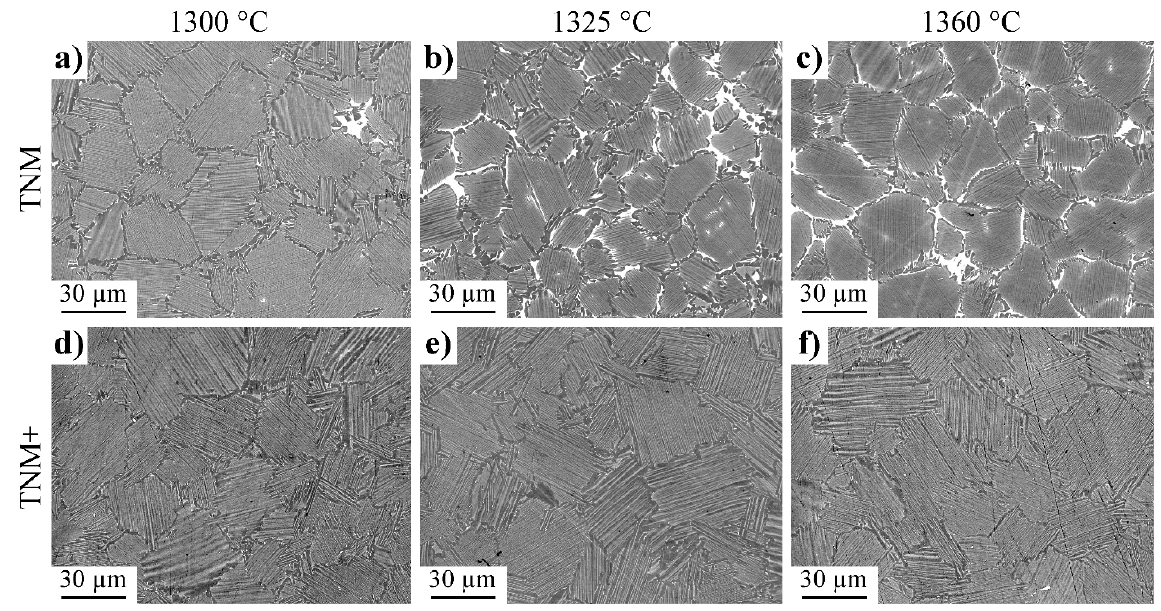
Figure 1. SEM-BSE micrographs of the microstructures obtained by SPS at dwell temperatures of 1300 °C, 1325 °C and 1360 °C, respectively, for the TNM alloy ( a – c ) and the TNM + alloy ( d – f ). The microstructures consist of γ phase (dark), α 2 phase (bright grey) and, in the case of the TNM alloy, β o phase (white).